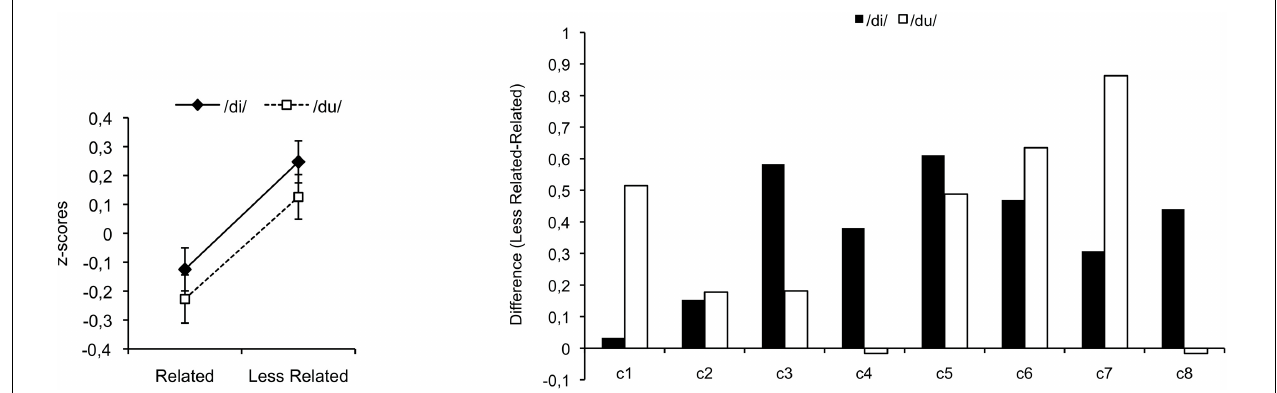
FIGURE 1 | Average data of the 8 control participants in Tillmann et al. (2008) on the left, and their individual data on the right [this group of control participants had a mean age of 65 ( ± 10) years]. For comparable data patterns of group of students, see Bigand et al. (2001) and Tillmann et al. (2008), of groups of children, see Schellenberg et al. (2005), and of another group of control participants as well as their individual data patterns, see Tillmann et al. (2007). Positive and negative values indicate facilitated processing for related and less-related targets,